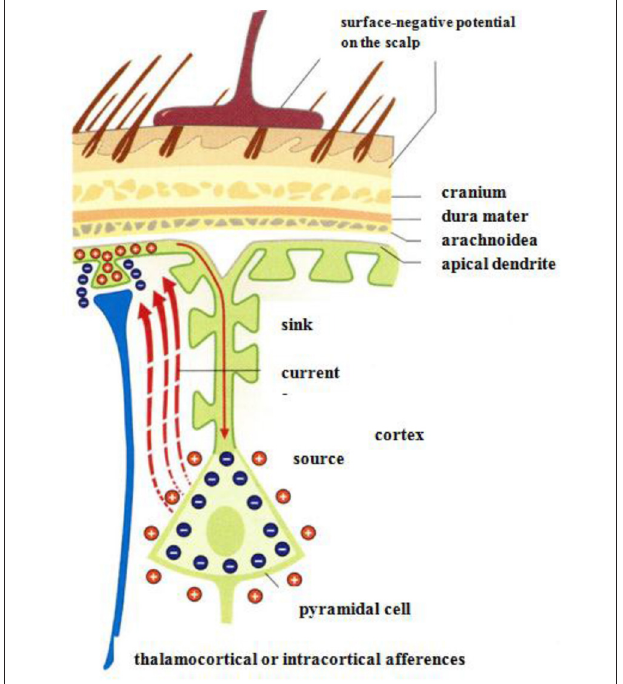
FIGURE 12 | Negative surface slow brain potentials on the skalp are generated by extracellular currents (red dashed arrows) which arise due to the electrical activation of apical dendrites by thalamocortical afferences (Birbaumer and Schmidt, 2010). Reprinted with permission from Birbaumer and Schmidt (2010) © 2010